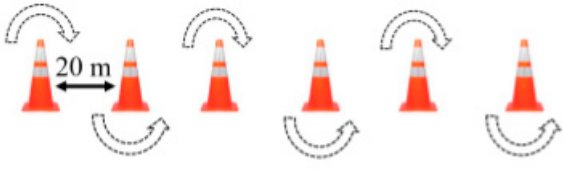
Figure 6. Structure of RBFNN.